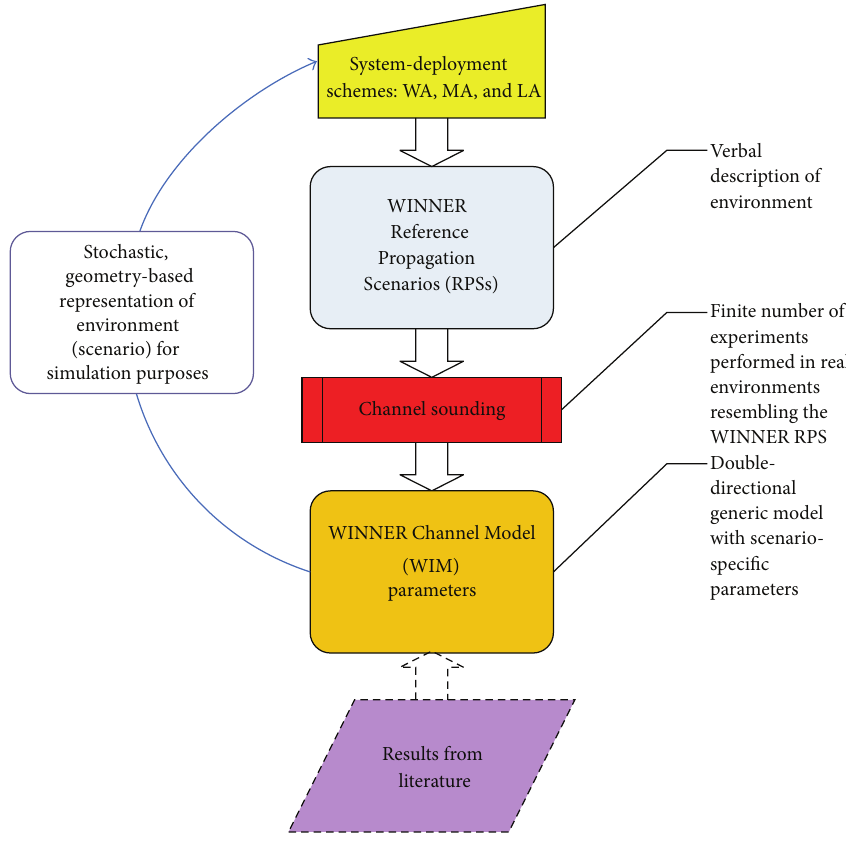
Figure 1: Genesis and representation of WINNER reference propagation scenarios [9].